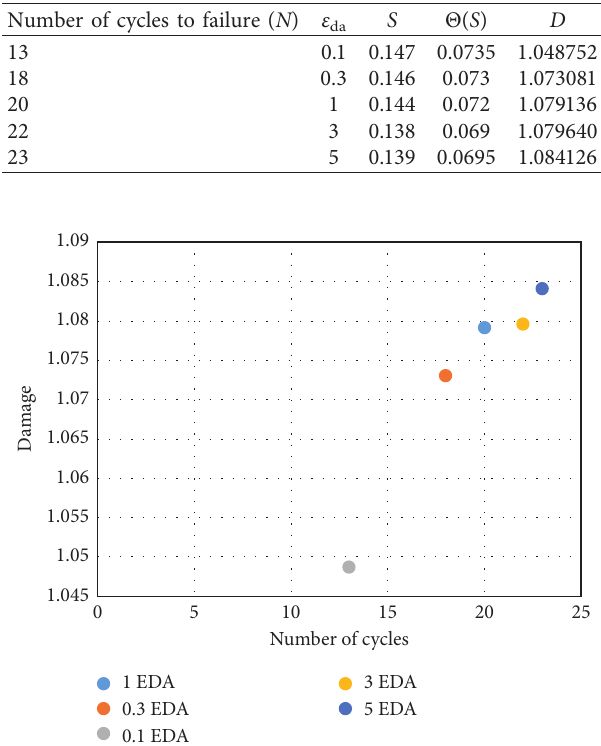
Figure 6: Comparison of change in D to